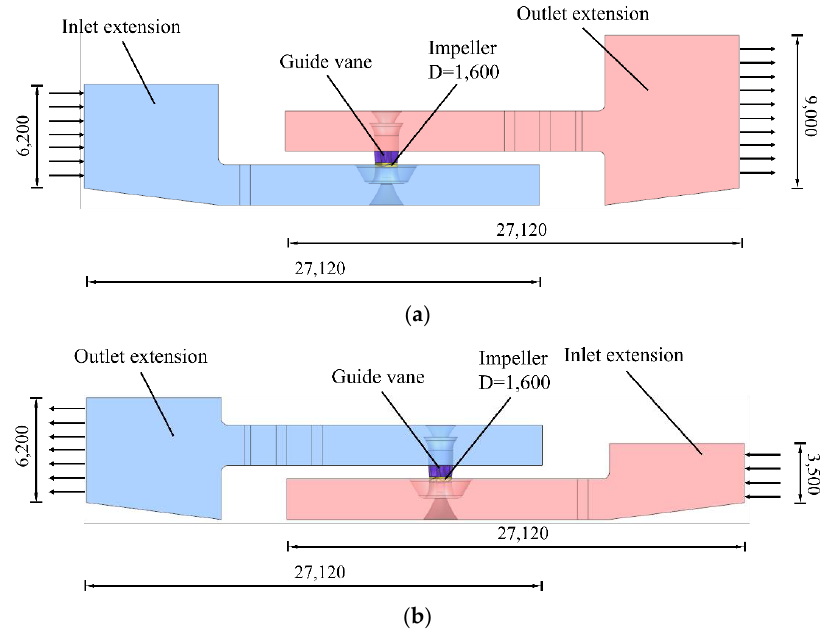
Figure 3. CFD calculation model of pump device: ( a ) drainage condition; ( b ) diversion condition.